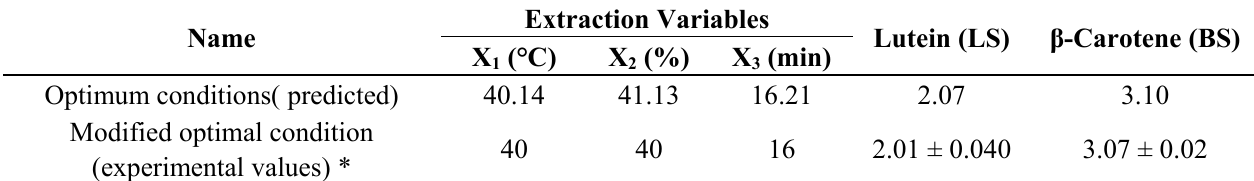
Table 3. Predicted and actual experimental values of lutein and β-carotene (μg/g) from spinach extracts under the modified optimal extraction conditions.